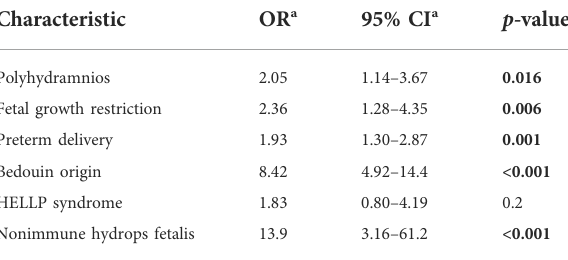
TABLE 4 Multivariate logistic regression — the association between pregnancy complications and newborns with inborn errors of